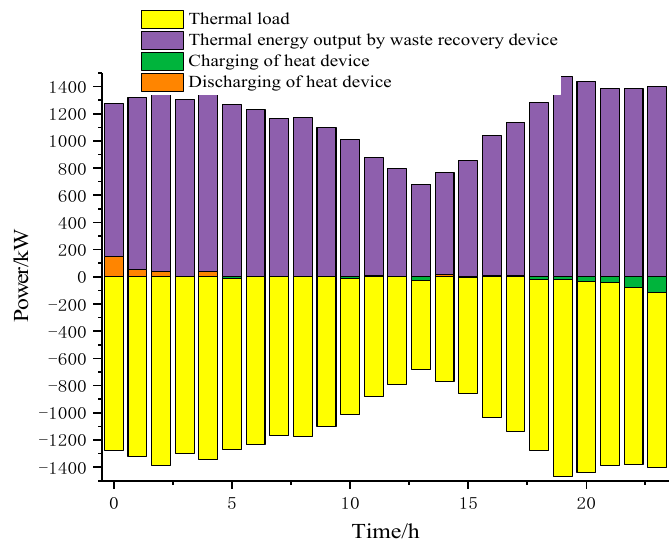
Figure 15. Electric power dispatch result of each unit in scenario 3. Energies 2019 , 12 , x FOR PEER REVIEW